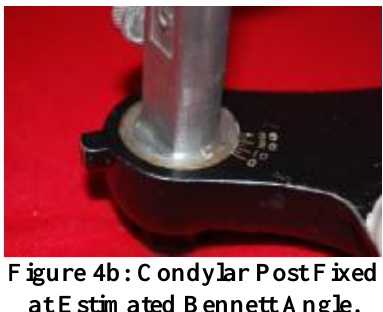
Figure 4b: Condylar Post Fixed at Estimated Bennett Angle.